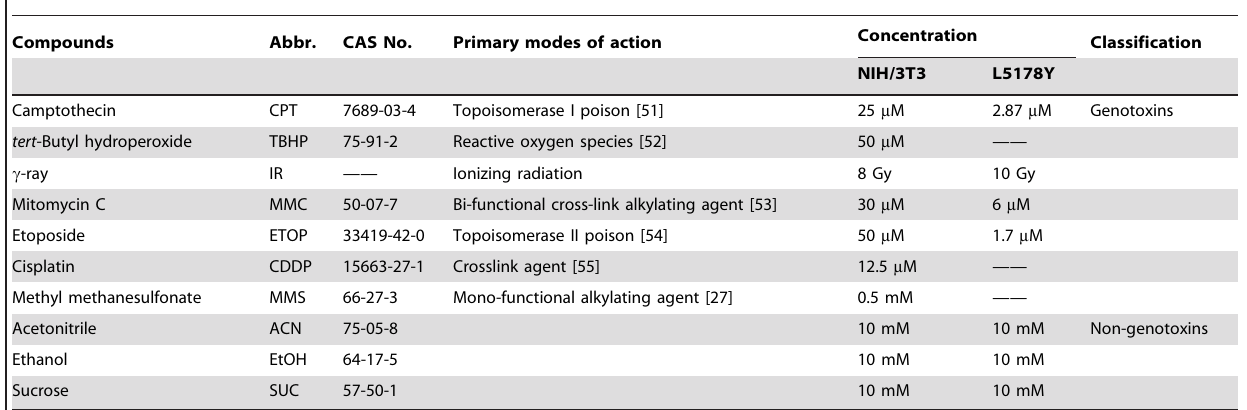
Table 3. Model compounds selected in the in vitro BC induction study.